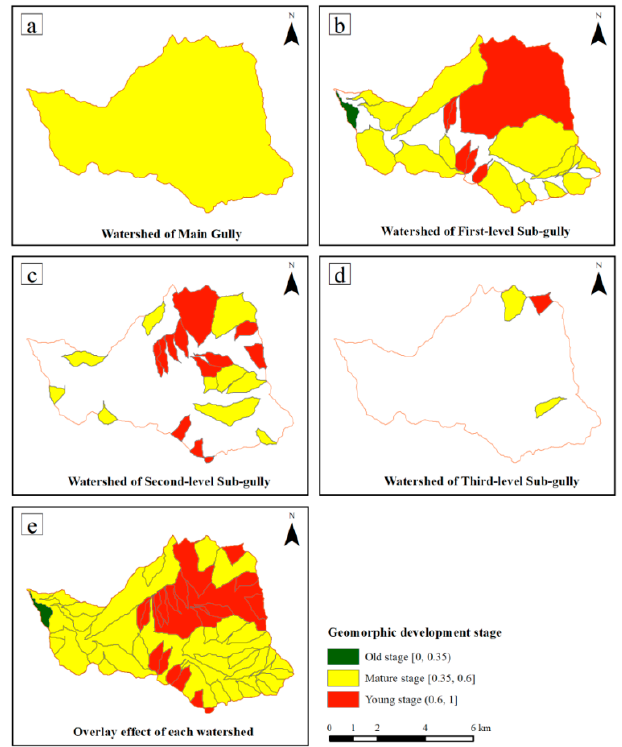
Figure 11. HI values of the different watershed levels. ( a ) Watershed of the main gully; ( b ) Watershed of the first-level sub-gully; ( c ) Watershed of the second-level sub-gully; ( d ) Watershed of the third-level sub-gully; ( e ) Overlay effect of each watershed.